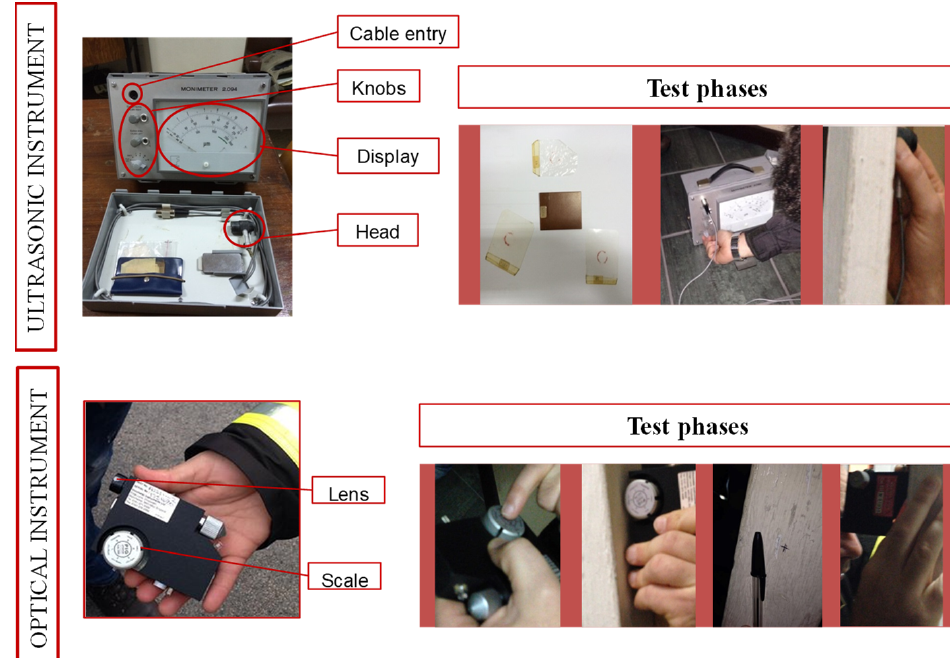
Figure 13. Example of DFT measurement gauges.